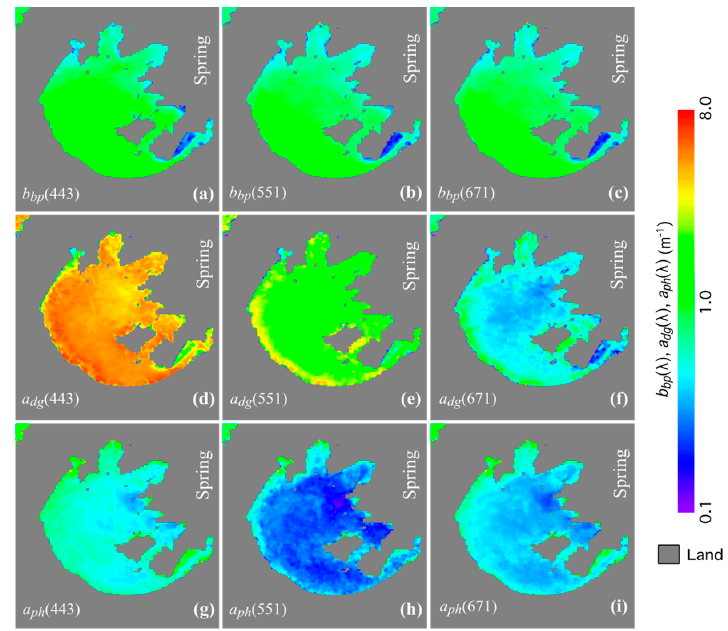
Figure 6. VIIRS-derived IOP in Lake Taihu during the spring season between 2012 and 2018 for (a–c) b bp ( λ ), (d–f) a dg ( λ ), and (g–i) a ph ( λ ) at the VIIRS bands of 443 nm (left column), 551 nm (middle column), and 671 nm (right column).